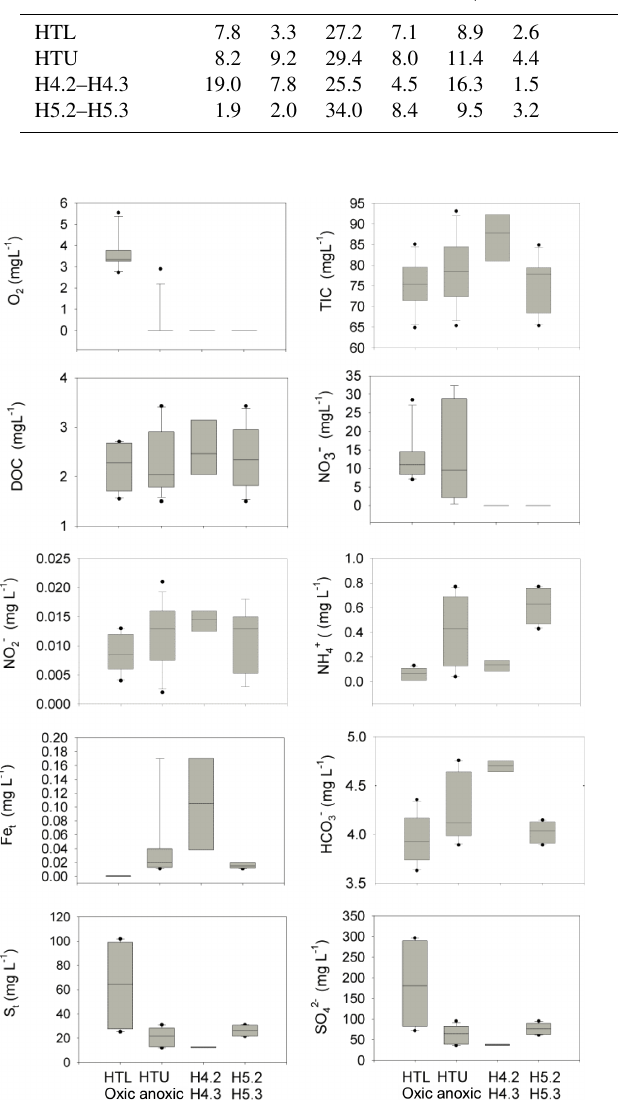
teria (G + ) in both HTU and HTL (Table 3: mean G + / G − ratio = 0.4 ± 0.2). The highest values of the G + / G − ratios were in the anoxic wells H4.2 and H4.3 (mean 0.7 ± 0.1). A PCA analysis explained 56.5 % of the PLFA